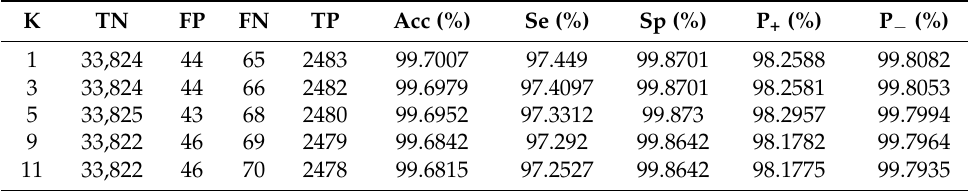
Table 12. The performance of the KNN classifier with different K values.